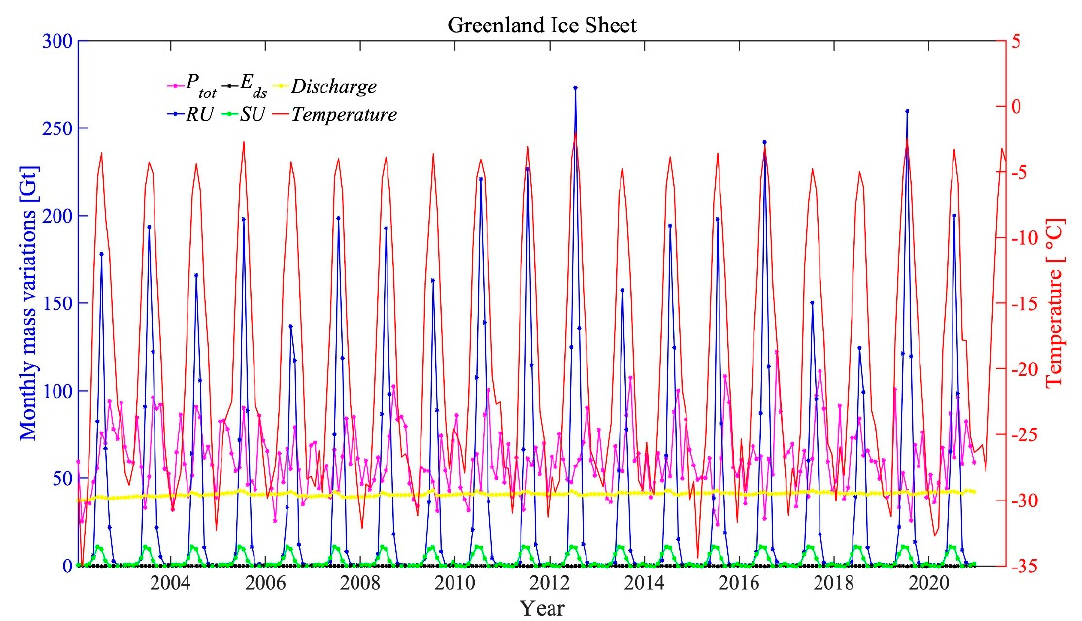
Figure 7. The factors impacting mass change of the GrIS. The following abbreviations are used: total precipitation ( P tot , magenta with asterisk), meltwater runoff ( RU , blue line with asterisk), sublimation ( SU , green line with asterisk), and erosion/deposition ( E ds , black line with asterisk), discharge (yellow line with asterisk), and temperature (red line).